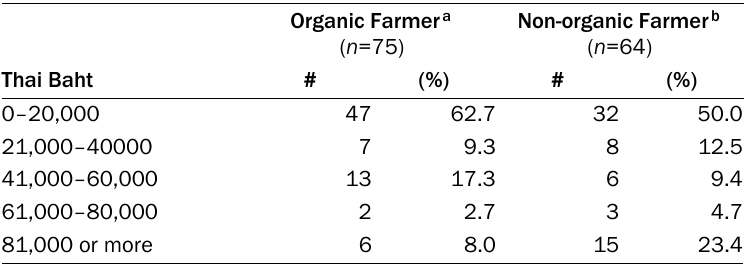
Table 6. Differences in the Non-Agricultural Income Range between Organic and Non-Organic Farmers (2013) Organic Farmer a